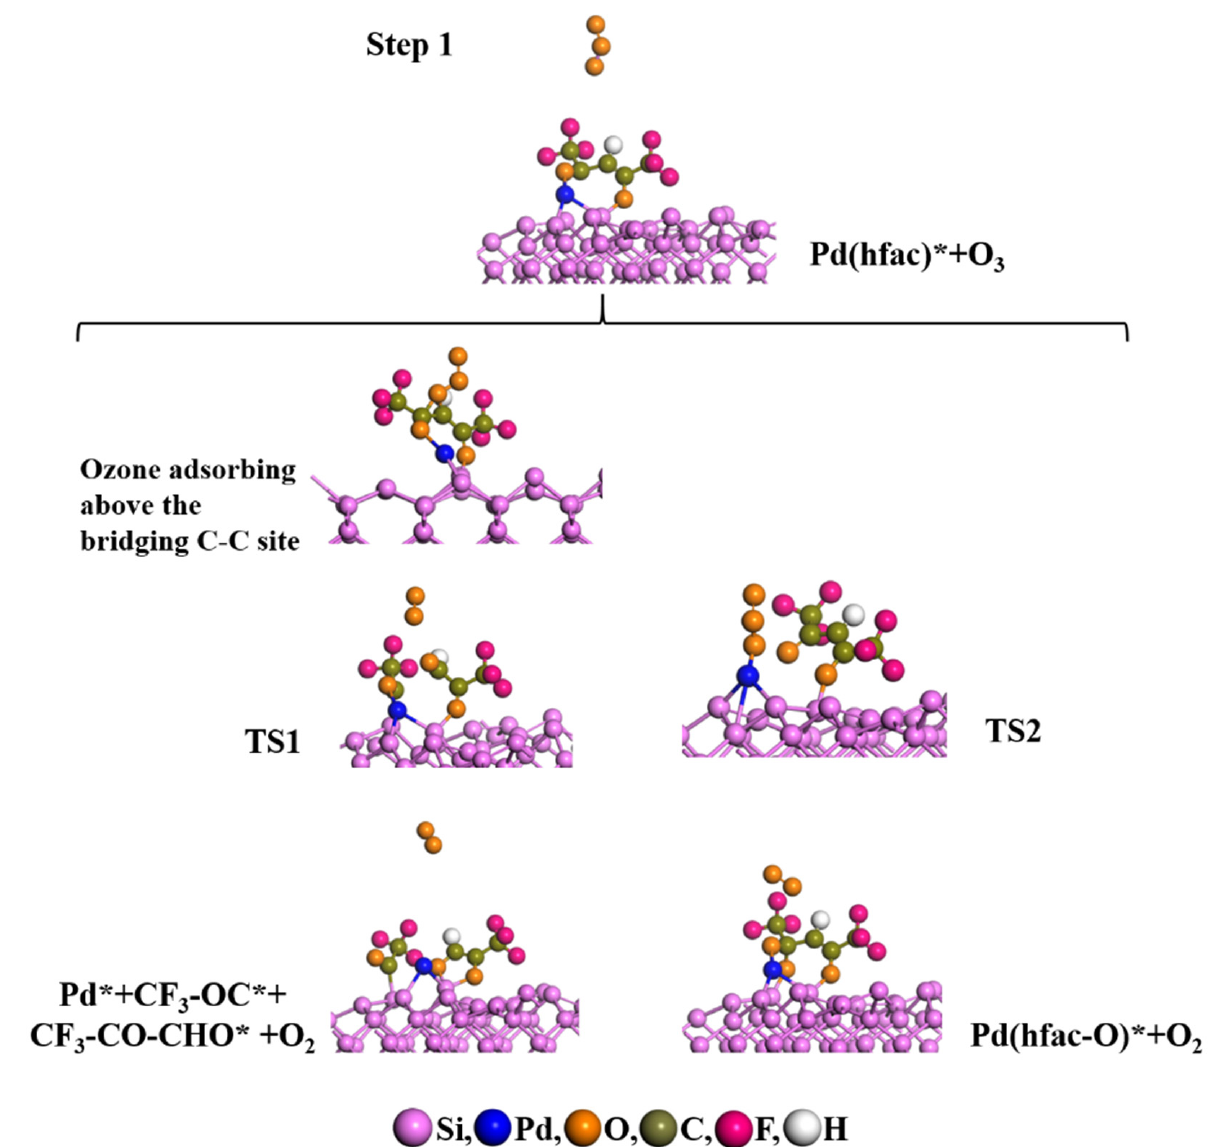
Figure 4. Reaction between Pd(hfac)* and ozone on the clean Si (100) surface represented by snapshots. There were two reaction pathways as another ozone approached the Pd(hfac-O)*, (step 2, Figure 3). Figure 5 shows the optimized reactant, transition state, and product structures. The reaction between ozone and Pd(hfac)-O* at the C–C bridging position could have formed a stable structure with an activation barrier of 0.42 eV and adsorption energy of − 3.14 eV, shown in Figure 3 (orange lines) and Figure 5, which was similar to the reaction described in Figure 3 (green lines) and Figure 4. The final products were Pd*, adsorbed CF 3 –CO 2 , and CF 3 –CO–CHO*. The latter two might then have been oxidized to form CO 2 , H 2 O, and gaseous